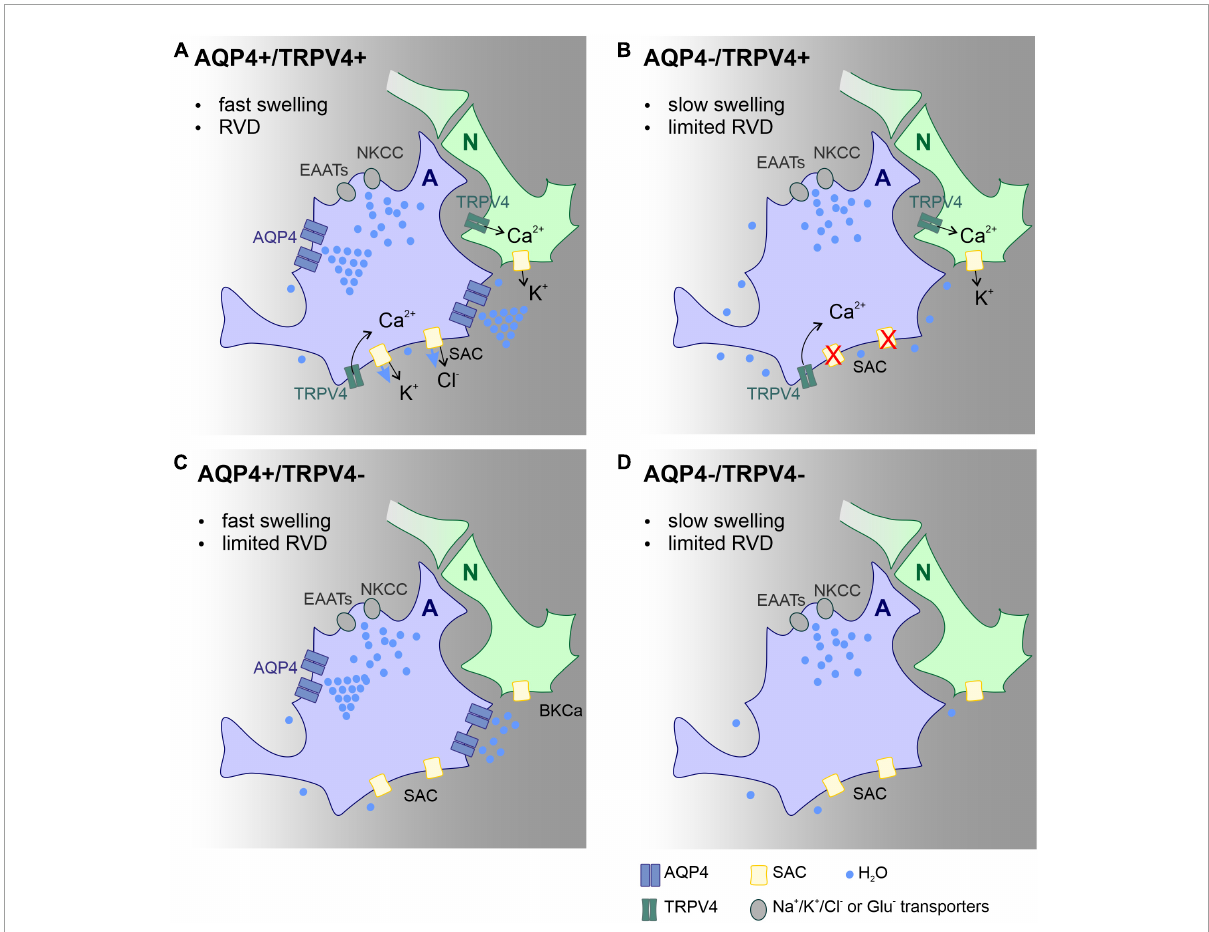
FIGURE5 Scheme of the main mechanisms involved in astrocyte volume changes and volume regulation in the acute post-ischemic phase, effect of AQP4 and TRPV4 channel deletion. Proposed mechanisms explaining the changes in the lesion size observed in the Ctrl (A) , AQP4 − / − (B) , TRPV4 − / − (C) , and AQP4 − / − /TRPV4 − / − (D) mice. We propose that the absence of AQP4 in single (B) or double knock-outs (D) leads to slowed swelling that is insufficient to trigger regulatory volume decrease (RVD). Such a decrease in RVD presumably occurs due to low activity of TRPV4 channels, which is unable to activate SACs in panel (B) , or lack of TRPV4 channels in panel (D) . Water entry into the cell occurs via ion/glutamate transporters, while its efflux occurs besides ion channels by simple diffusion. Deletion of TRPV4 results in the absence of RVD activated by cell membrane stretch. Both slower swelling and limited RVD in double knock-outs, lead to less edema in the acute post-ischemic phase compared to control. Panels (B,D) both display limited swelling as well as RVD however in AQP4 − / − (B) functional TRPV4 channels in neurons prolong neuronal activity with further neurotoxic impact on nervous tissue. A, astrocyte; N, neuron; Ctrl, control; AQP4 − / − , AQP4-deficient mice; TRPV4 − / − , TRPV4-deficient mice; AQP4 − / − /TRPV4 − / − , AQP4- and TRPV4-deficient mice; RVD, regulatory volume decrease; NKCC, Na + /K + / Cl − co-transporter; SAC, stretch activated ion channel; EAAT, excitatory amino acid transporter; AQP4, aquaporin-4 channel; TRPV4, Transient receptor potential cation channel subfamily V member